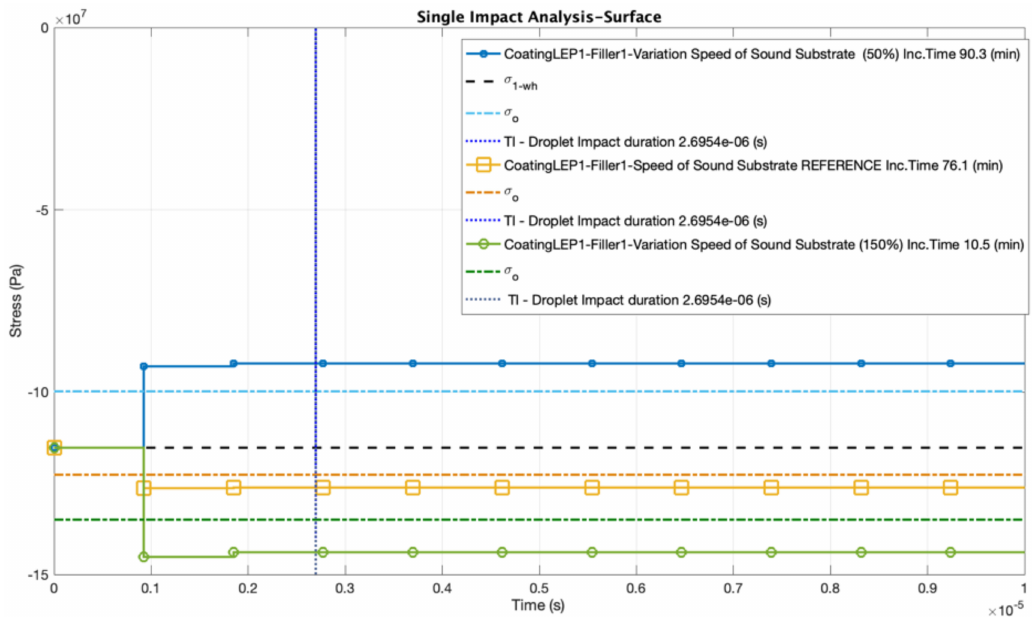
Figure 11. Surface stress evolution analysis for simulated material LEP prototype comparing 50% variation of Filler Substrate Speed of